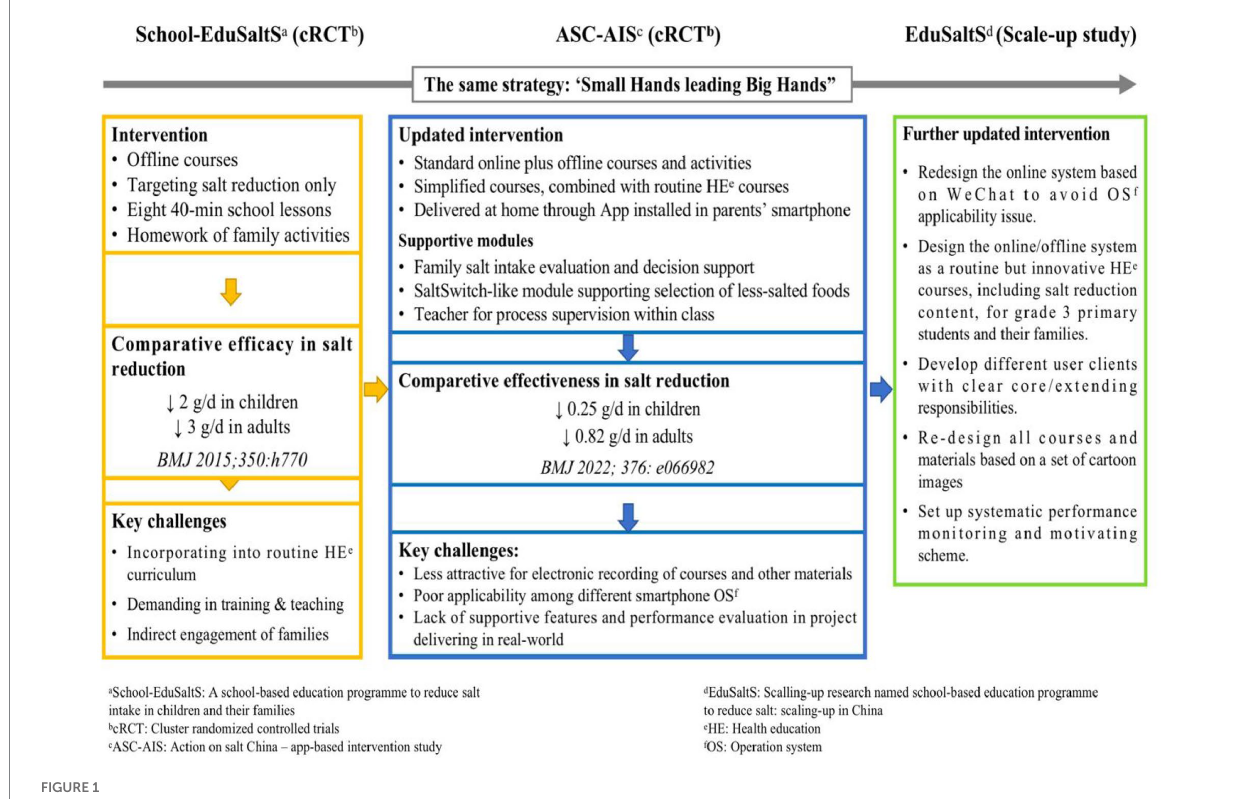
FIGURE 1 The evolution of interventions from School-EduSalt, AppSalt to